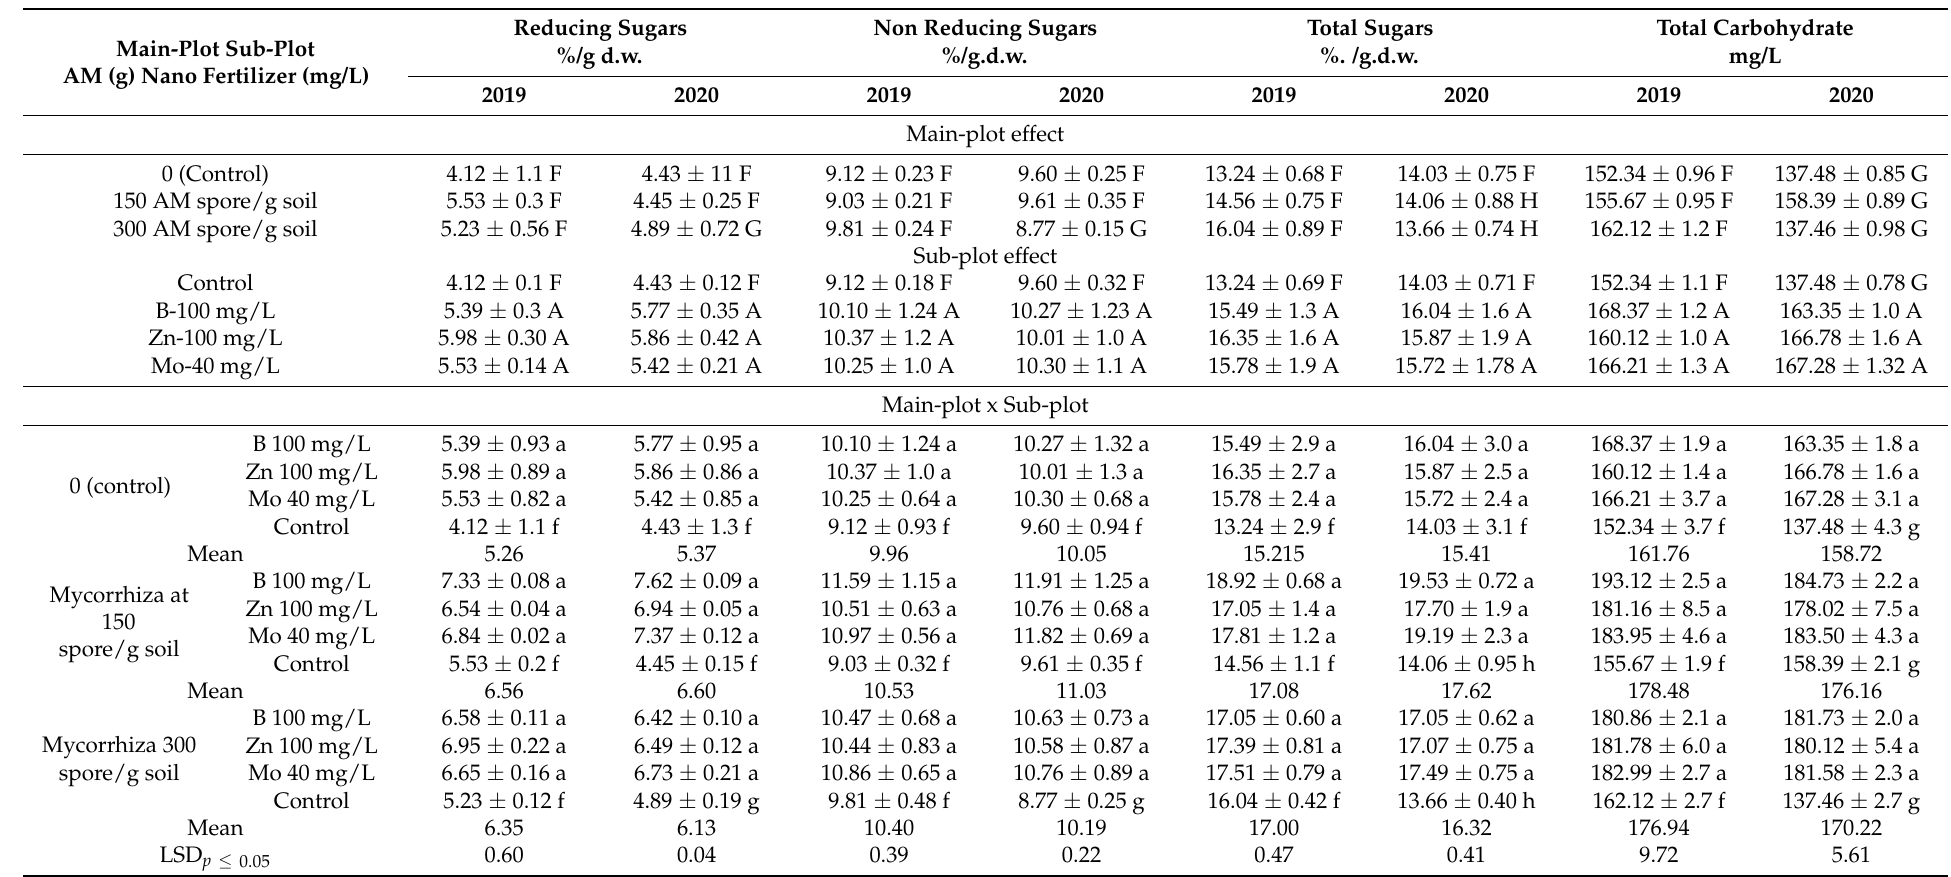
Table 5. Effect of arbuscular mycorrhiza (AM) and nano B, Zn, and Mo microelements on some bio constituents of stevia plants during 2019 and 2020 seasons. Main-Plot